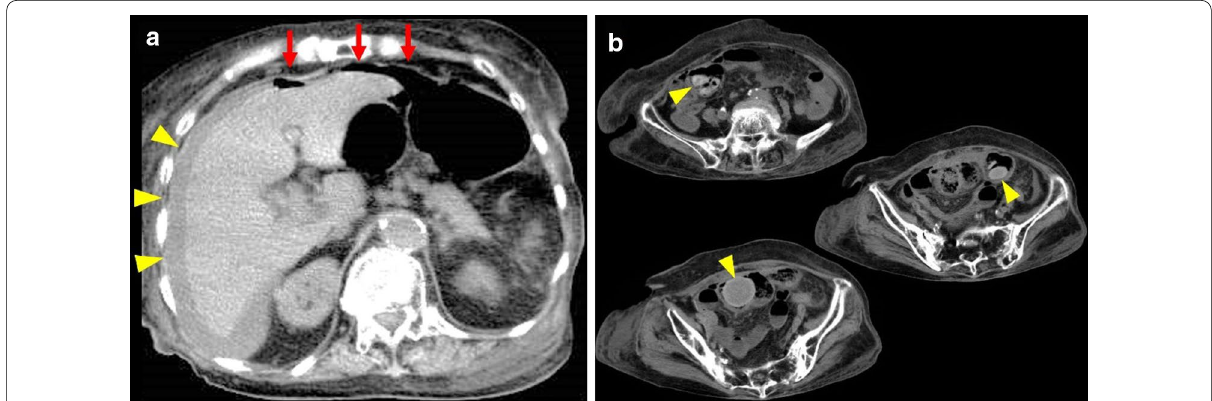
Fig. 1 Abdominal plain computed tomography (CT) imaging performed at the first visit to a previous hospital. a Free air in the upper abdomen (red arrows) and fluid collection in the right subphrenic space (yellow arrowheads); b slightly high-density structures located in an uncertain part of the intestine (yellow